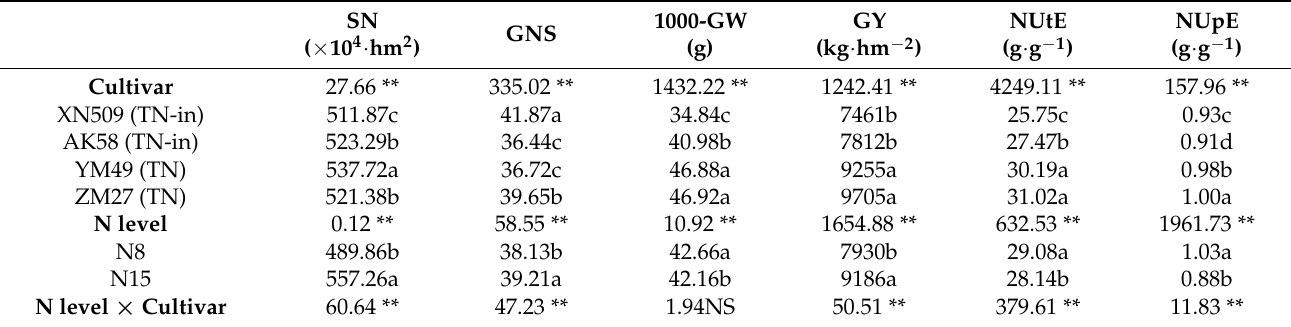
Table 2. Yield, yield components, and NUtE of two N-efficient and two N-inefficient winter wheat varieties under different N